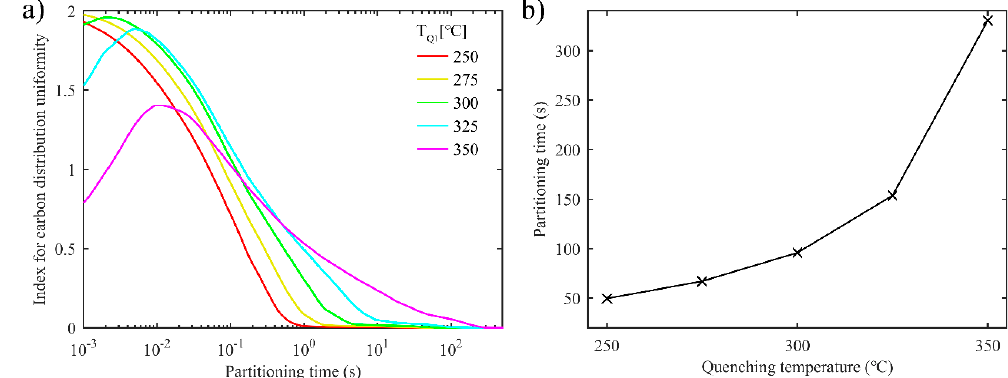
Figure 6. Uniformity of carbon distribution in austenite in the one-stage Q-P process. ( a ) The index for carbon distribution uniformity versus partitioning time; ( b ) The partitioning time when the carbon concentration reaches 3.1 wt.% in each grid of austenite versus first quenching temperature.